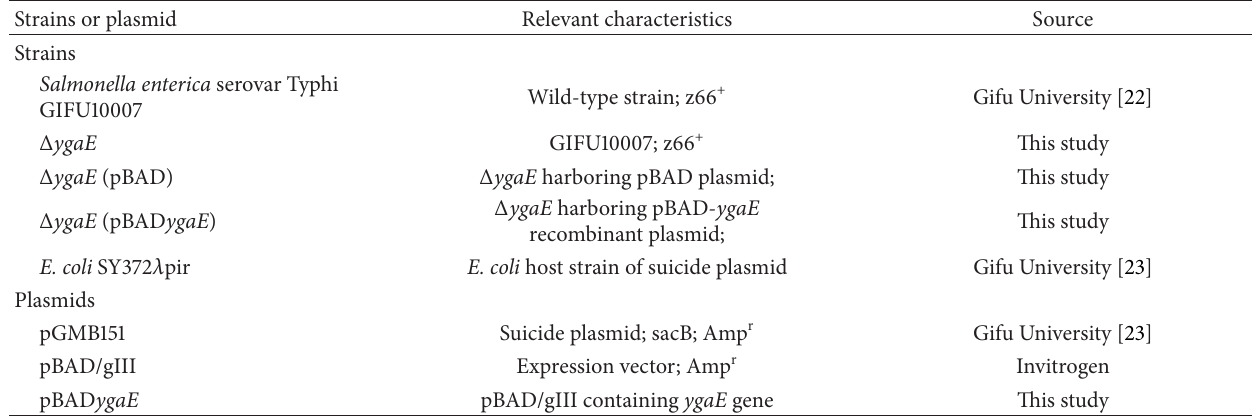
Table 1: Strains and plasmids used in this study.